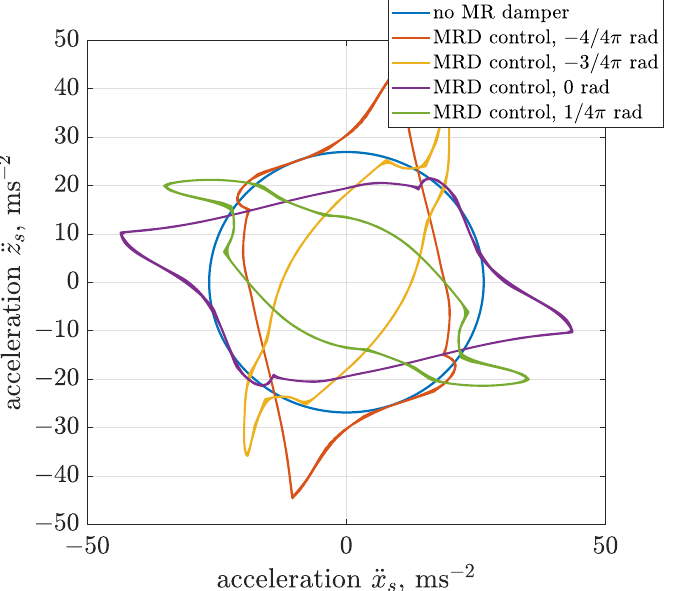
Figure 24. Different configurations of phase shift ∆ α alg dedicated to semi-active generation of linear trajectories of vibration acceleration using the dissipative domain of the Bouc–Wen MR damper model.